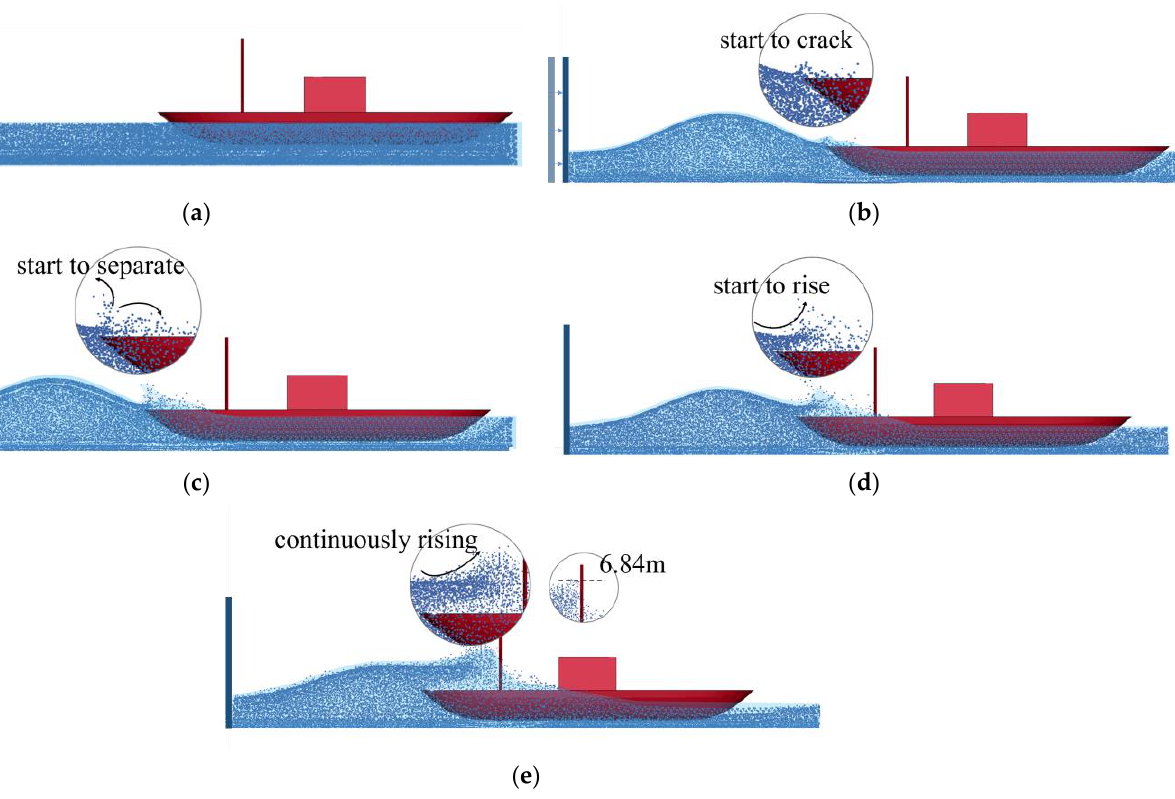
Figure 4. This is the sea spray generation process: ( a ) the ship is placed in the current particles, ( b ) waves begin to form sea spray, ( c ) sea spray particles start to disperse, ( d ) sea spray particles start to rise, and ( e ) sea spray particles continue to rise to the highest point.